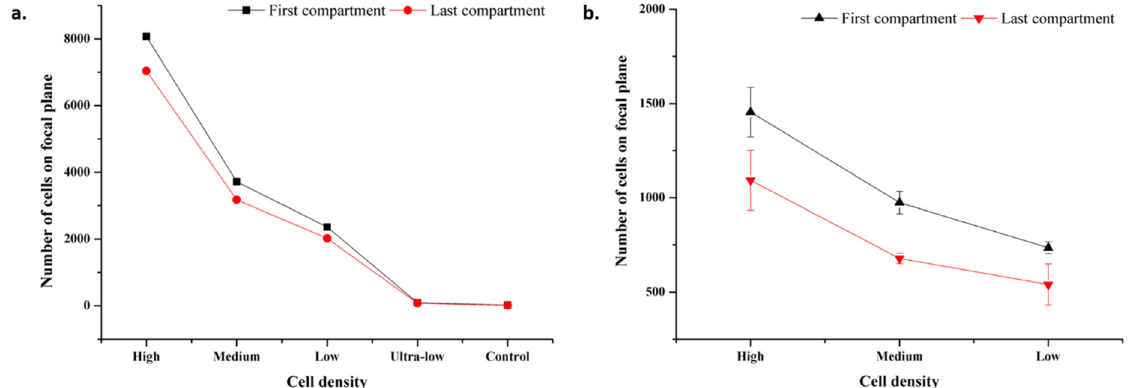
Figure 8. Microscopic and mobile images focal plane analysis results. ( a ) Microscopic image analysis results for cell densities at high, medium, low, ultra-low cell, and control. Standard deviation bars are lower than 15. As scale increment value is 1000, standard deviation bars cannot be seen. ( b ) Mobile image analysis results for cell densities at high, medium, and low.